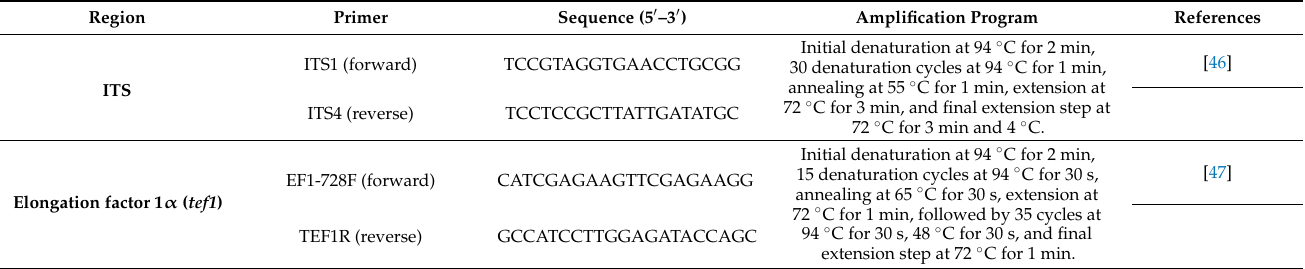
Table 4. Primers and amplification